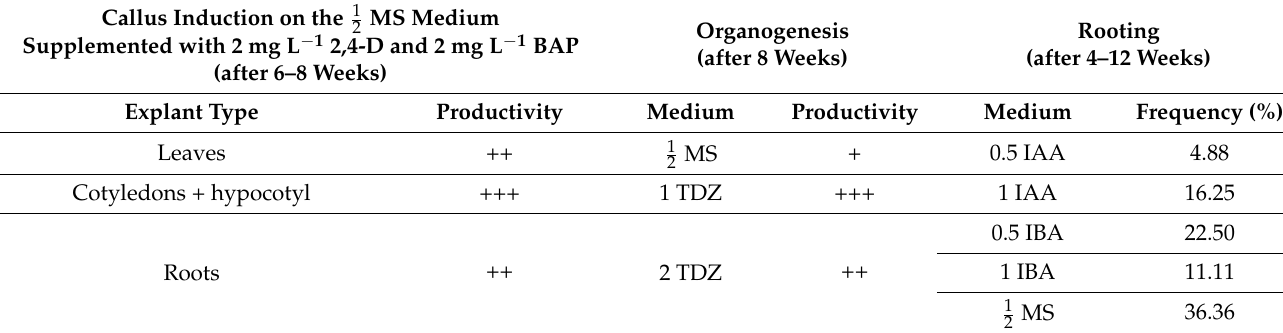
Table 1. Callus induction, organogenesis, and rooting in Arabidopsis arenosa on tested explants and media (1/2 MS medium with or without additives). The numbers in front of the growth regulator abbreviations are values in mg L − 1 . +, ++, +++—low, moderate, high productivity, respectively. Experiments were performed in duplicate to triplicate; N (number of explants) ≥